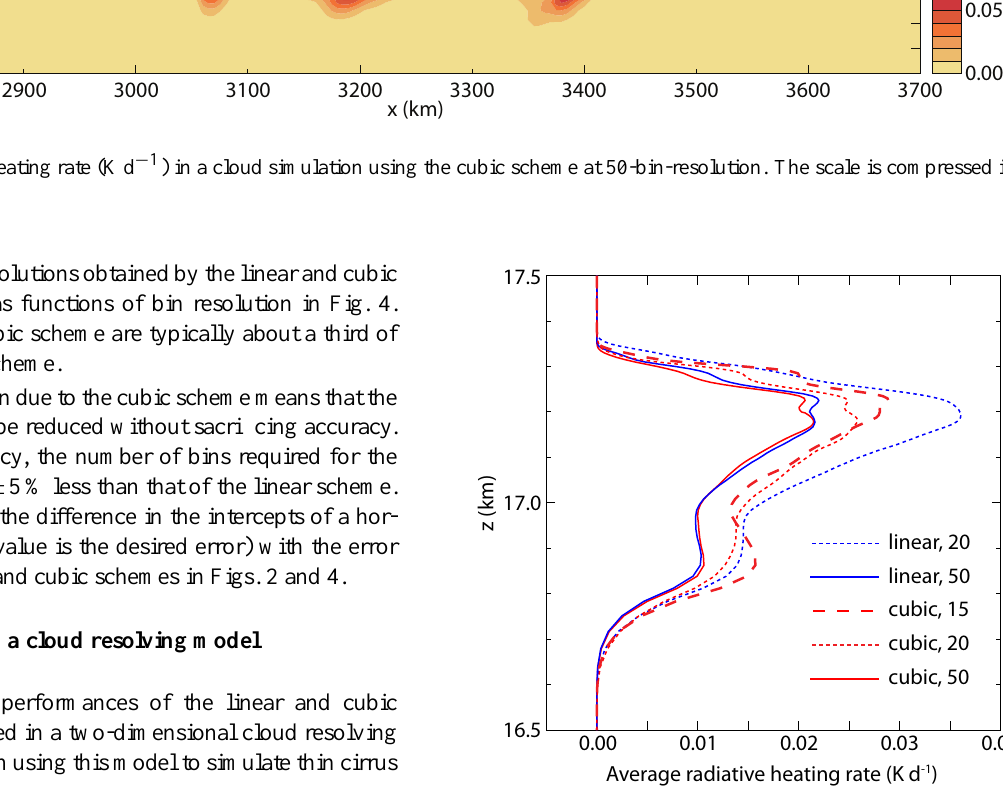
Fig. 6. Radiative heating, averaged over the same range of x as in Fig. 5, obtained by using the linear scheme at 20 and 50 bins and the cubic scheme at 15, 20 and 50